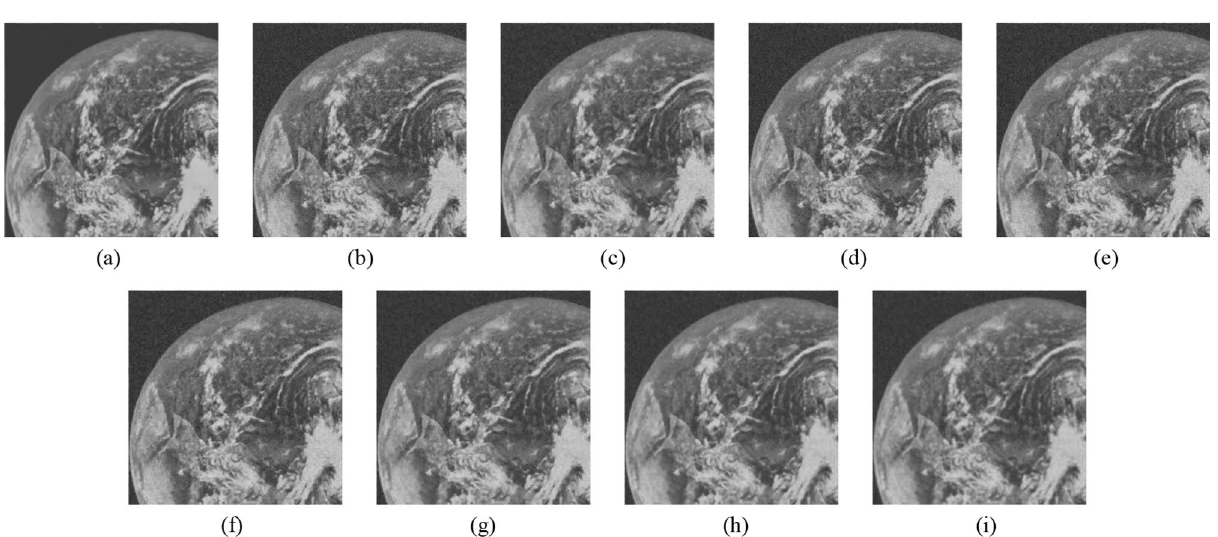
Figure 24. Comparison of denoising performance of each filter against the Gaussian noise (“Balloon”). ( a ) Original image; ( b ) noise-added image; ( c ) filtered image using abwFMGFI; ( d ) filtered image using FMGFI (BW = 1 level); ( e ) filtered image using FMGFI (BW = 3 level); ( f ) filtered image using FMGFI (BW = 5 level); ( g ) filtered image using FMGFI (BW = 11 level); ( h ) filtered image using FMGFI (BW = 21 level); ( i ) filtered image using FMGFI (BW = 51 level).